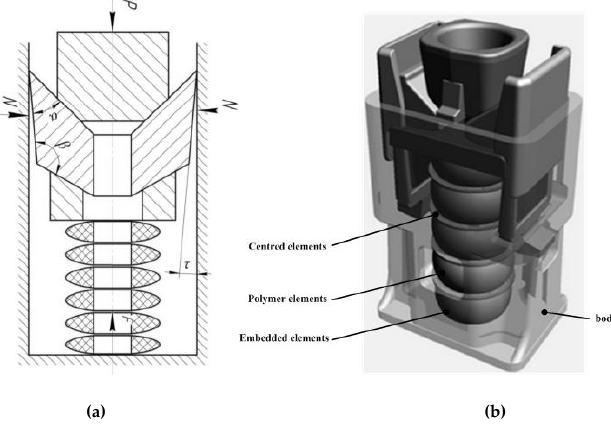
Figure 2. Elastic-frictional absorption device principle scheme (a) with package of polymer elements